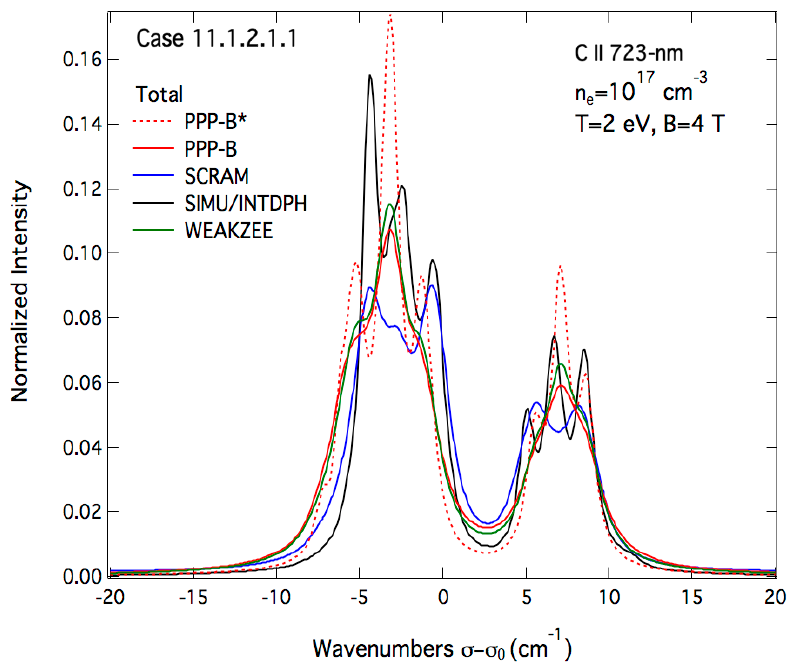
Figure 7. Comparison of the total Stark–Zeeman profiles of the C II 723-nm line as computed by the different line-shape modeling codes for the same conditions as in Figures 5 and 6 with an angle of observation of 90° with respect to the magnetic field